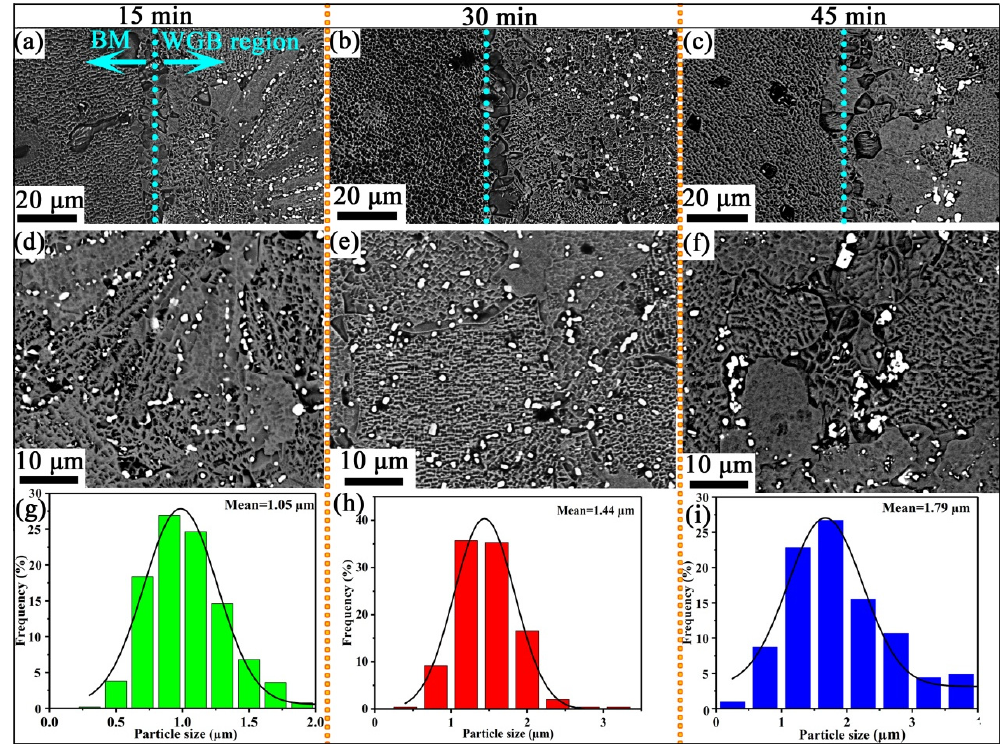
Figure 3. Backscattered electron micrographs of brazed joint ( a , b , c ) and wide-gap brazed (WGB) region ( d , e , f ) bonded at different brazing times. The size distribution of the M 3 B 2 phase ( g , h , i ) in the WGB region brazed at different brazing times.